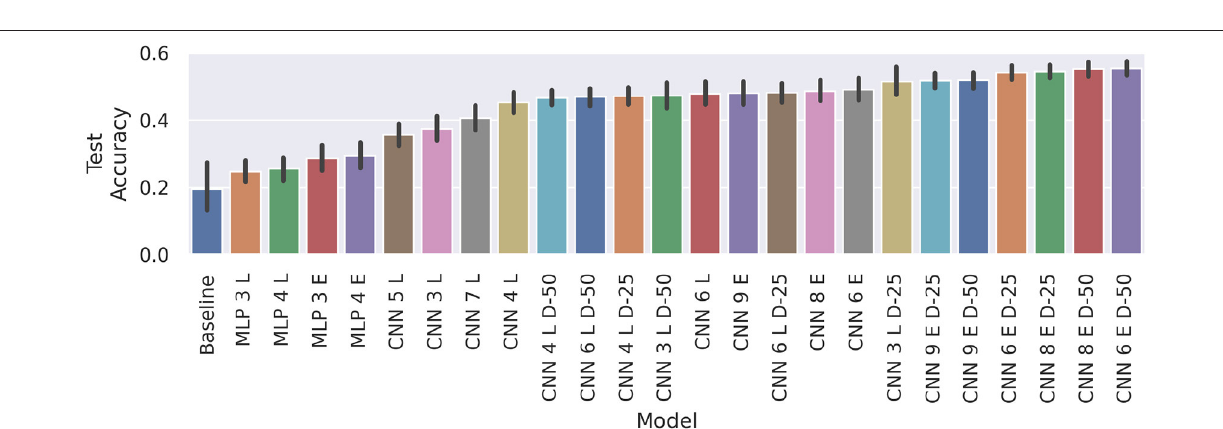
FIGURE 13 | Comparison of average cross-session test accuracy on subject E with learned calibration and our baseline. The black vertical lines display the 95% confidence intervals. Again, every train/test setup was trained five times on each model, to achieve statistical robustness. Suffixes “E” and “L” denote early and late fusion architectures,